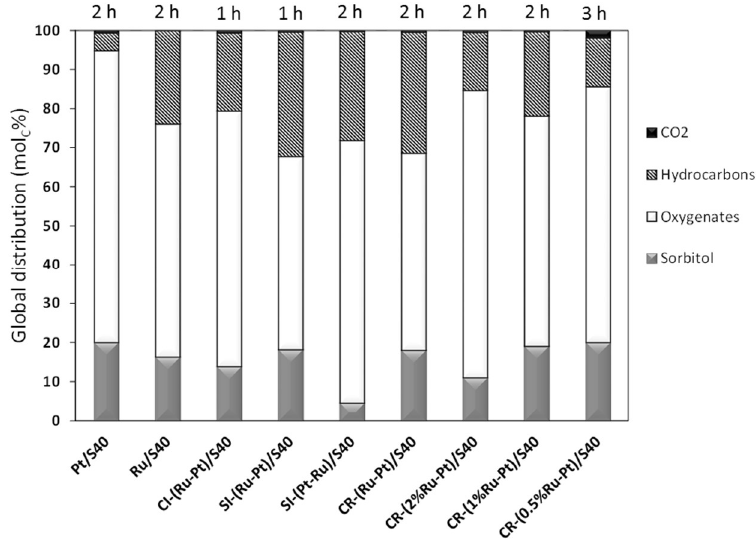
Figure 6. Carbon global distribution obtained at 80–96% sorbitol conversion for the Ru–Pt/S40 bimetallic catalysts prepared by co-impregnation (CI), successive impregnations (SI) and catalytic reduction deposition (CR), as well as for Pt and Ru monometallic catalysts.